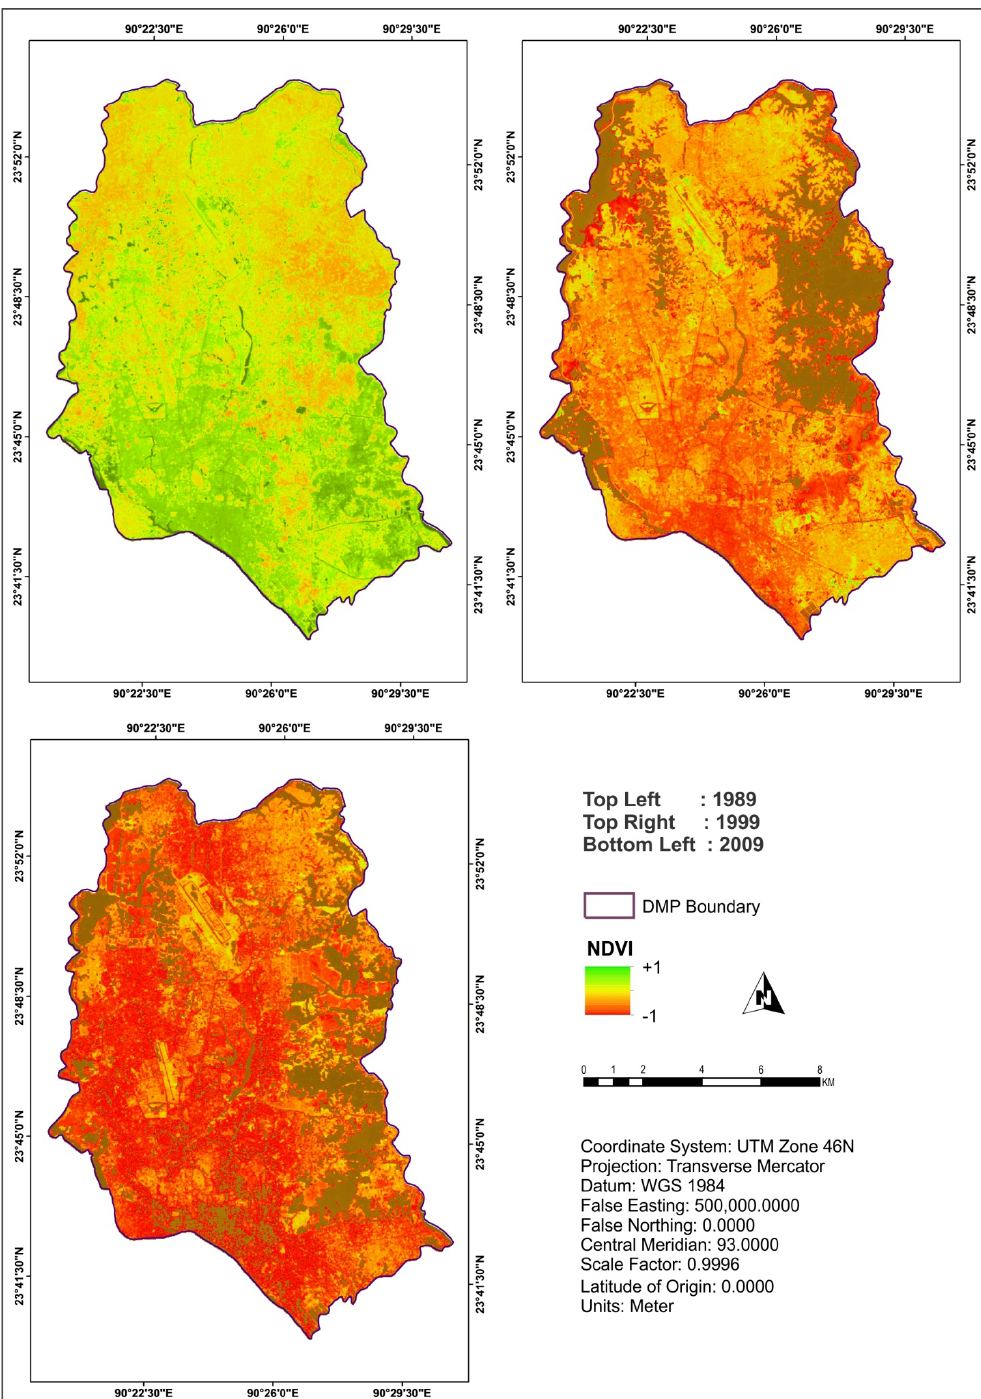
Figure 5. NDVI distributions in DMP area